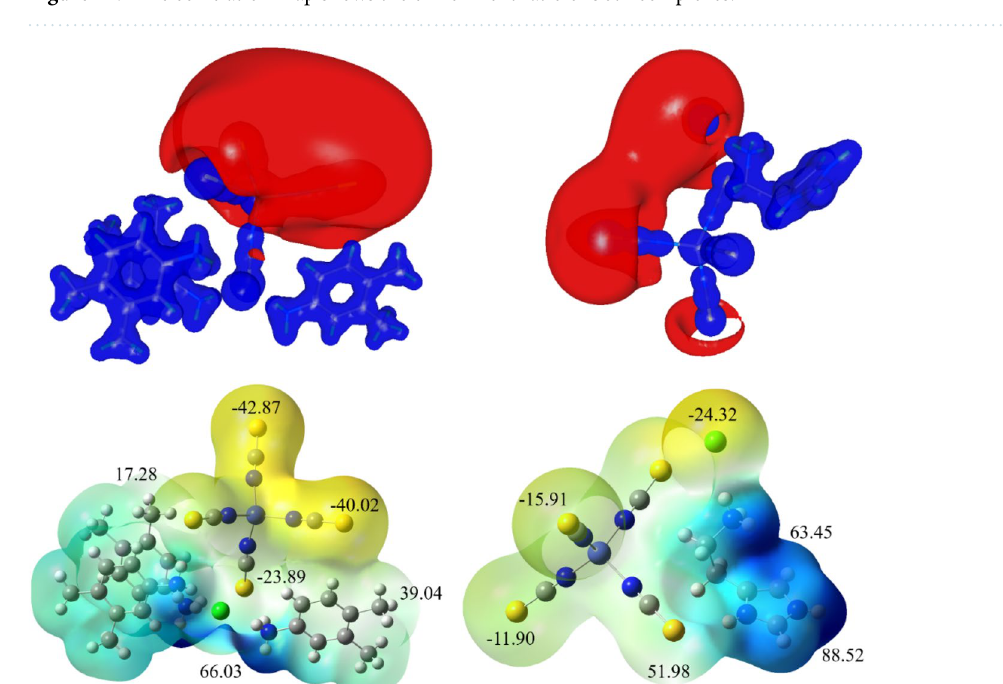
Figure 13. Electrostatic potential map of both metal–organic